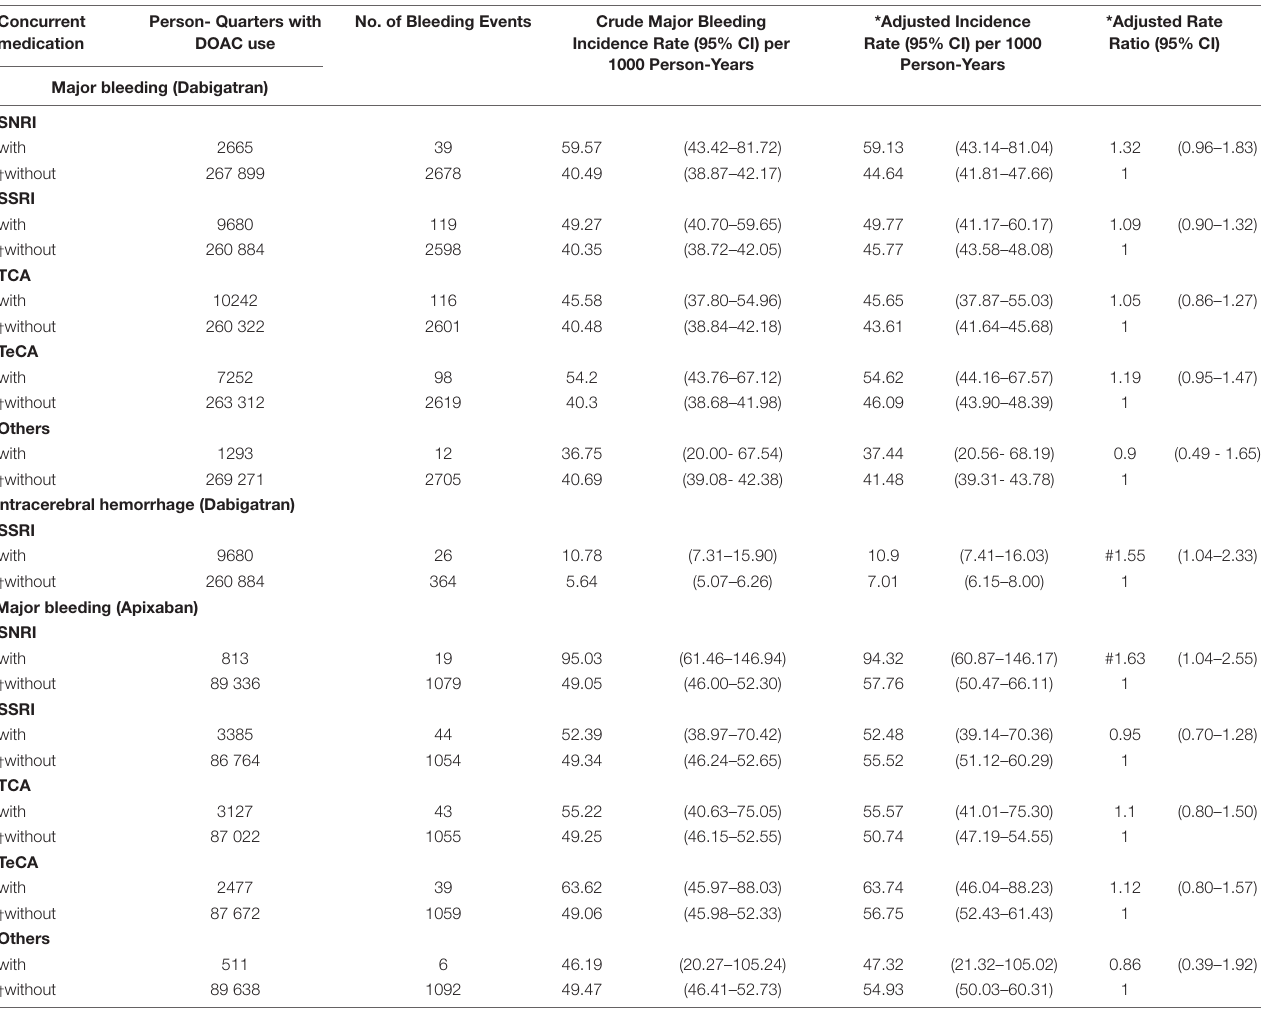
TABLE 6 | Risk of major bleeding among patients with AF taking dabigatran/apixaban with or without concurrent antidepressants. Concurrent